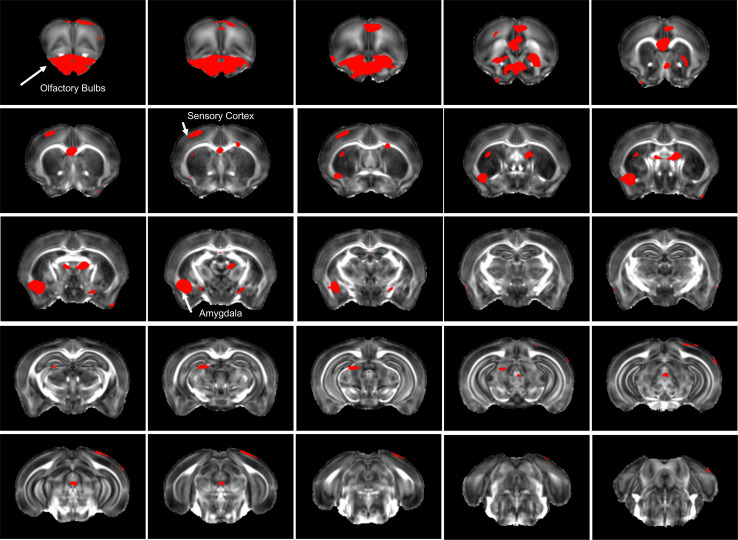
Areas that show potentially significant interactions between unpredictable postnatal stress and sex for volumetric changes using voxel-based morphometric analysis (p<0.05 uncorrected, minimal cluster size = 20 voxels).n = 6 per rearing condition and sex.